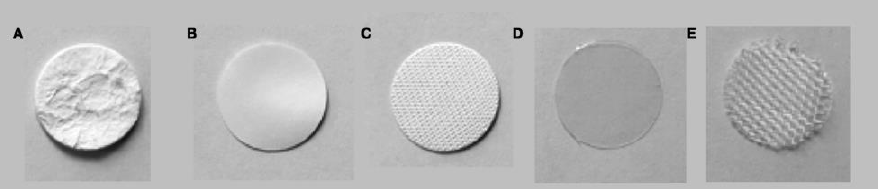
Figure 1. Samples of the test membranes (( A ) NCL-P; ( B ) NCL-E; ( C ) ECL-B), the non-porous poly- ester membrane ( D ), and the carrier mesh ( E ). polyester membrane ( D ), and the carrier mesh ( E